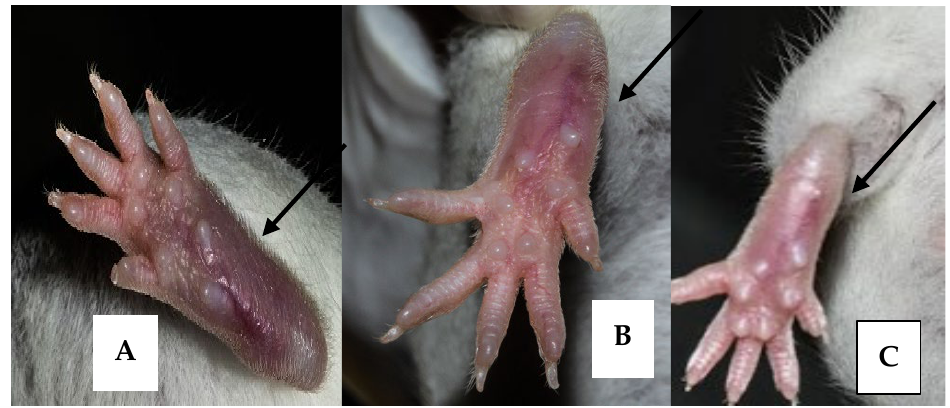
Figure 6. In vivo efficacy of 10-hydroxy chondrofoline in an experimental model of CL. Data are represented as mean ± standard deviation ( n = 6). Statistically significant differences are given as ** represents p < 0.002 and * p = 0.002. 3. Discussion For authorization of a drug, one of the most essential parameters is that the given compound should not be toxic to the host cells. For this purpose, we evaluated the cyto- toxicity of our compounds and the standard drug on THP1 cells by using a trypan blue exclusion assay. The in vitro results exhibited 10-hydroxy chondrofoline to be the most potent drug as compared to meglumine antimoniate. The rationale behind the inadequate effectiveness of meglumine antimonate might be due to resistance developed by the L. tropica HTD 7 strain as meglumine antimonate show different responses to different Leish- mania species, e.g., Jain et al. reported IC 50 values from 10 µg/mL (susceptible strain) to more than 128 µg/mL for the resistant strain of L. panamensis. This response of the re- sistance strain resembles our results; as mentioned before, meglumine antimonate is the normal therapy used in Afghanistan, so this strain may have developed resistance against meglumine antimonate [26]. Combination therapy is effective in the elimination of various